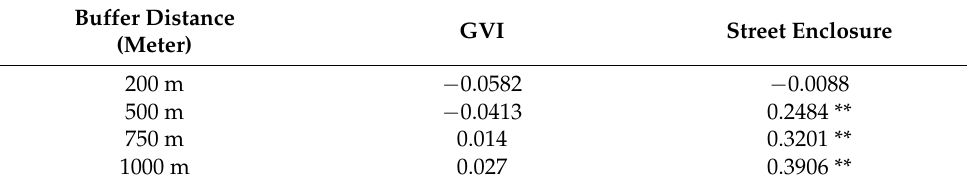
Table 2. Pearson correlation coefficients between GVI and enclosure and the number of cases at different buffer